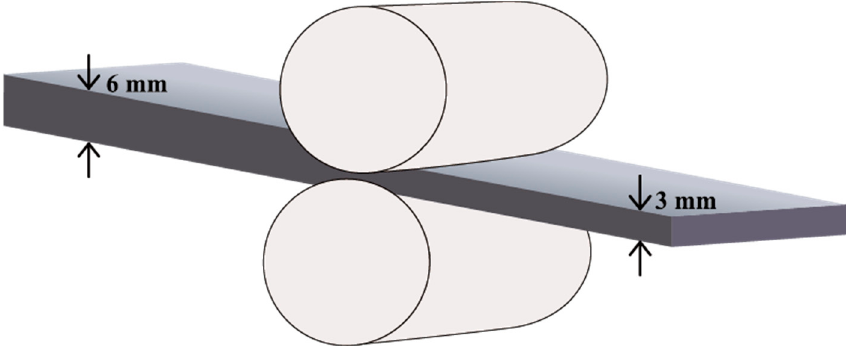
Figure 1. Rolling process: Mg plate was rolled from 6 mm to 3